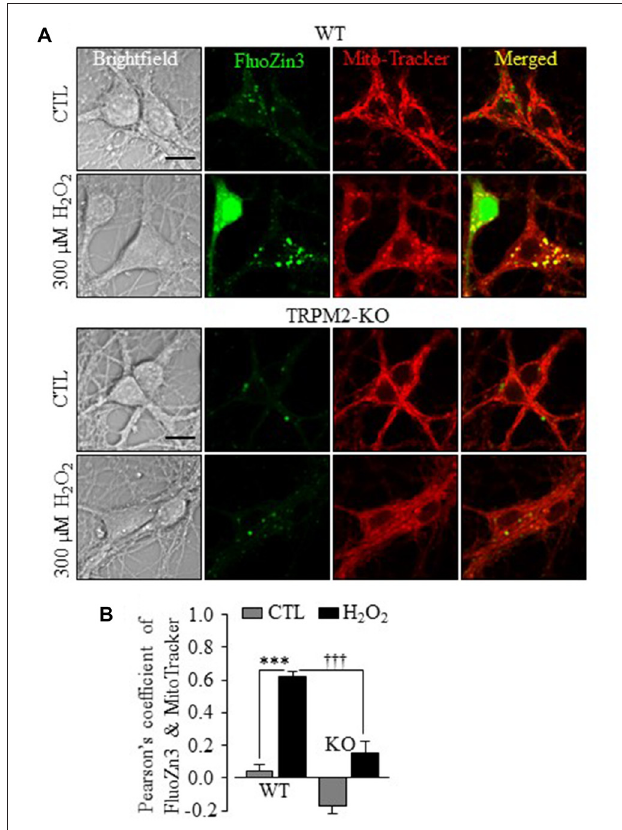
FIGURE 4 | TRPM2 channel plays a critical role in H 2 O 2 -induced mitochondrial Zn 2 + accumulation in hippocampal neurons. (A) Representative confocal images showing FluoZin3 (green) and MitoTracker (red) in WT or TRPM2-KO neurons under control (CTL) or treatment with 300 µ M H 2 O 2 for 30 min. Scale bar is 10 µ m. (B) Mean Pearson’s correlation coefficient from three independent experiments with each experiment analyzing 12–18 neurons. ∗∗∗ p < 0.005 indicates difference from control, and ††† p < 0.005 indicates difference between WT and TRPM2-KO neurons treated with H 2 O 2